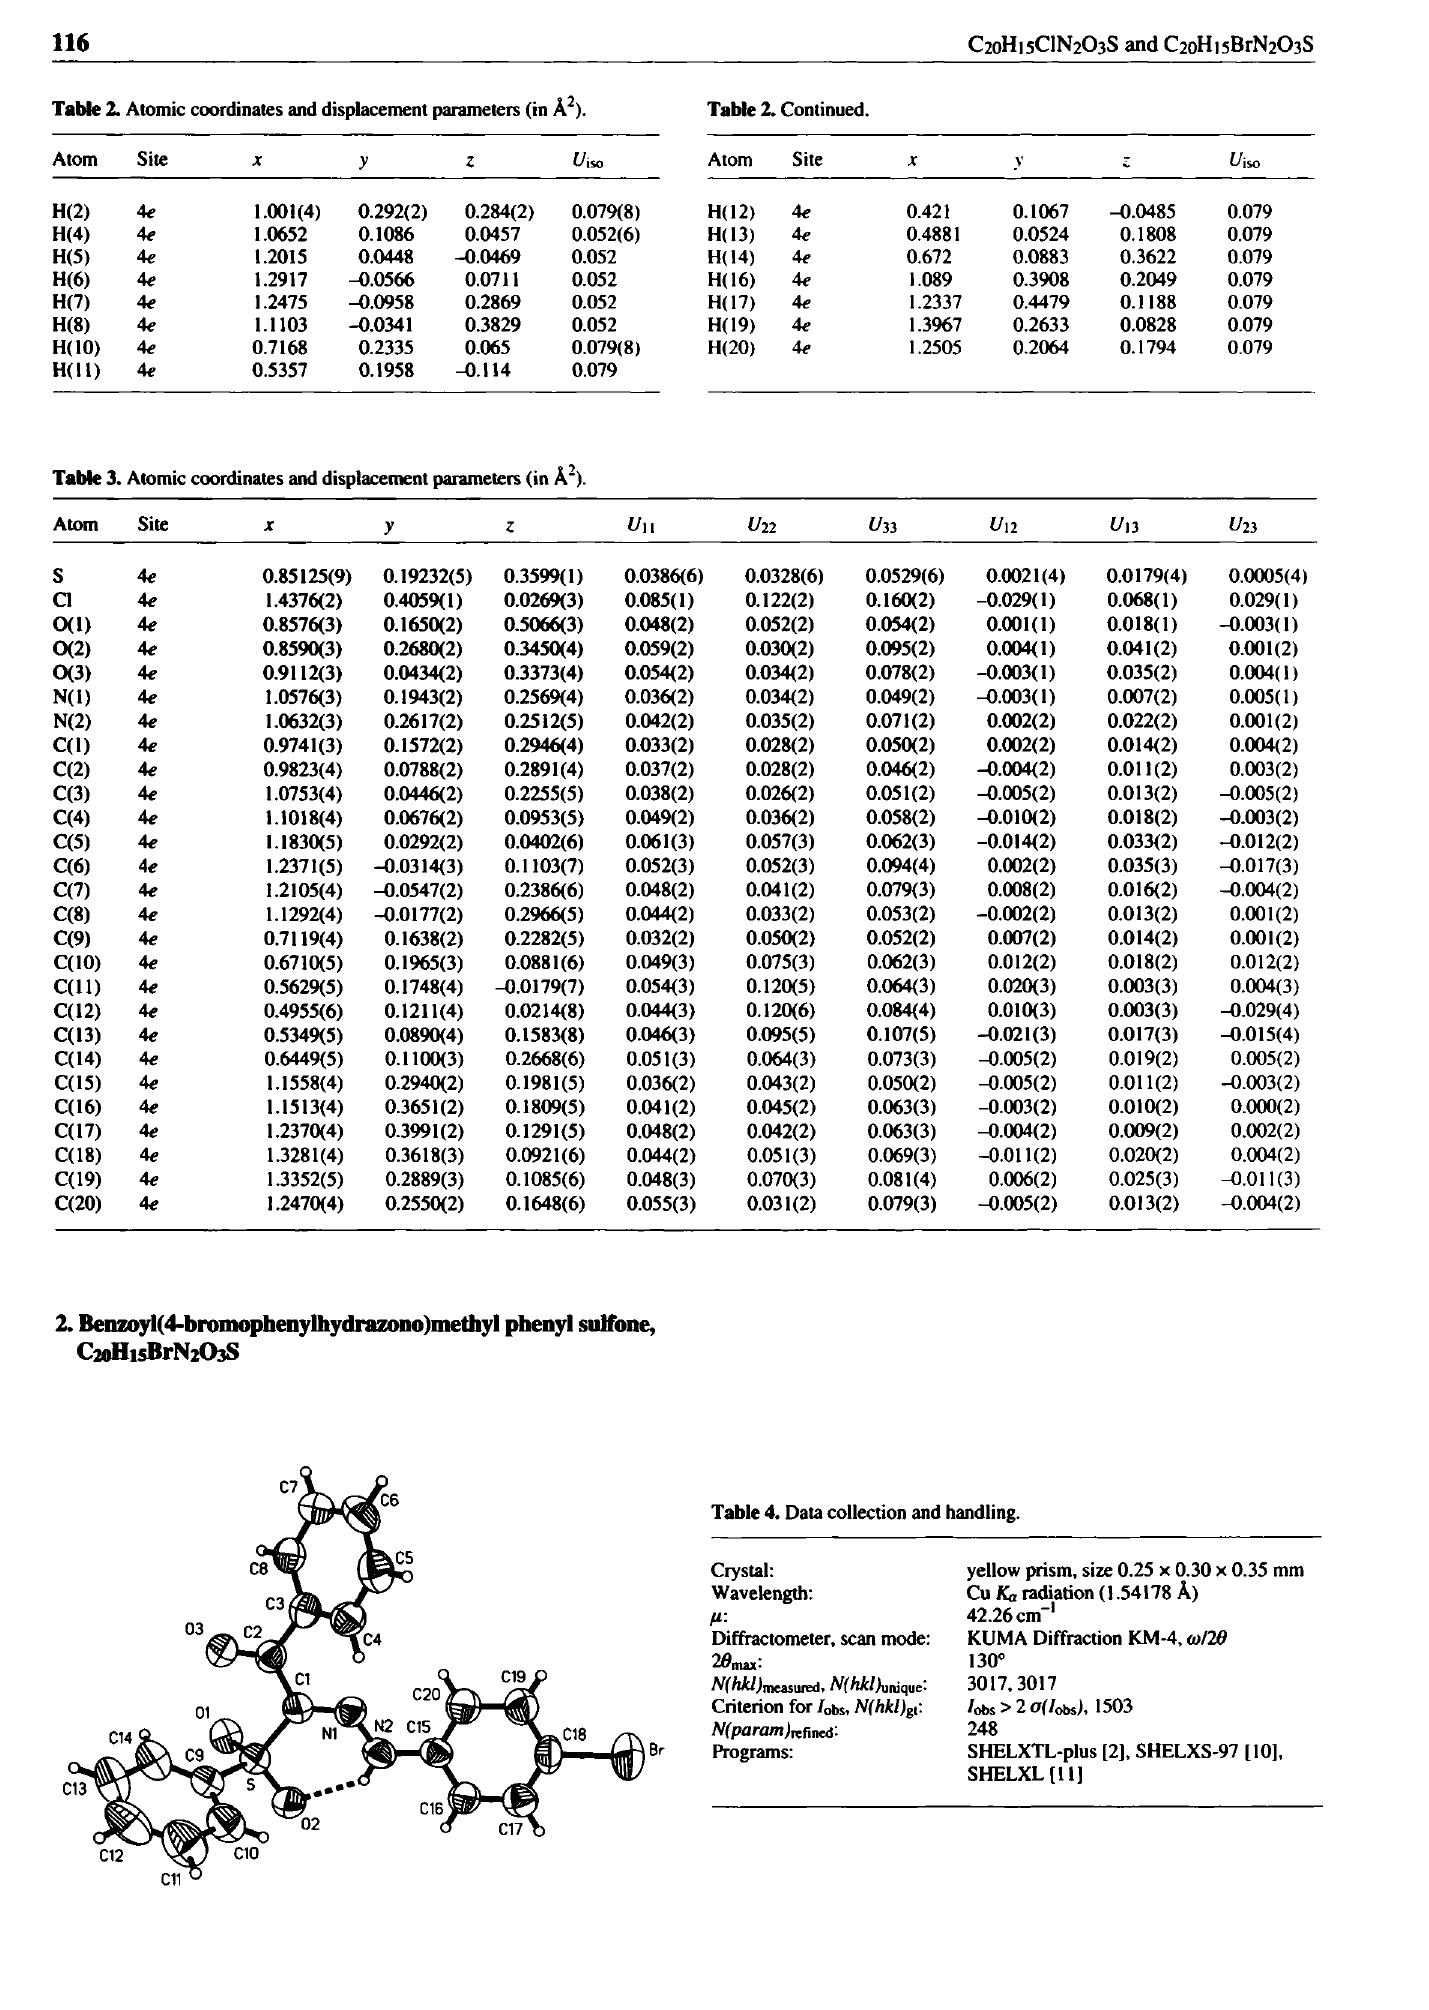
Table 2. Atomic coordinates and displacement parameters (in Â 2 ).